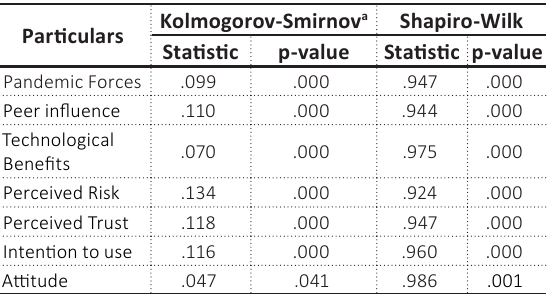
Table 2. Tests for